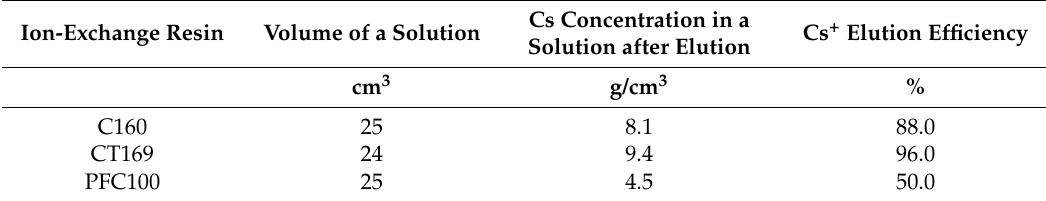
Table 3. Results of ion-exchange resin selection for cesium sorption.